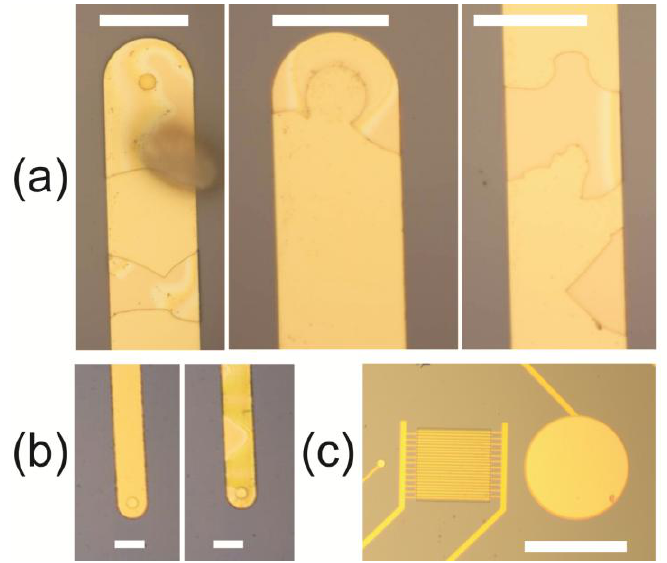
Figure 6. ( a ) Optical microscope images of electrodes and leads with visible cracks in the silicon oxide passivation layer; ( b ) The reference electrode before (left) and after (right) a CV was acquired. New cracks are visible after acquisition of the CV; ( c ) The three electrodes after fabrication, wafer dicing, cleaning and measurement. No cracks can be seen in the utilized silicon nitride passivation layer. Scale bars in (a) and (b) are 50 µm, and in (c) 700